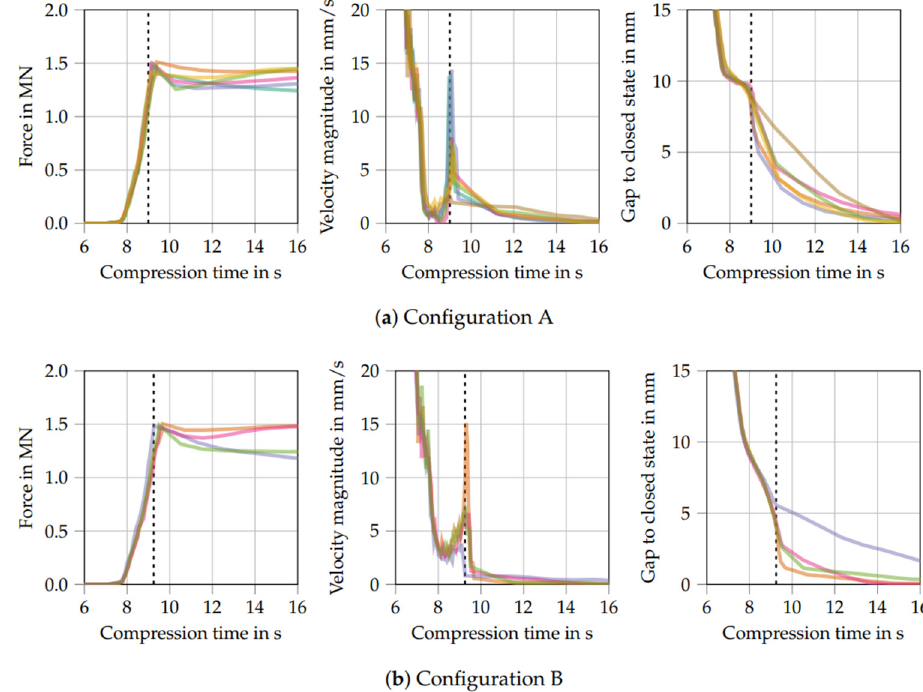
Figure 4. Press data from several parts molded in Configurations A and B. The dashed lines indicate the switch from displacement control to force